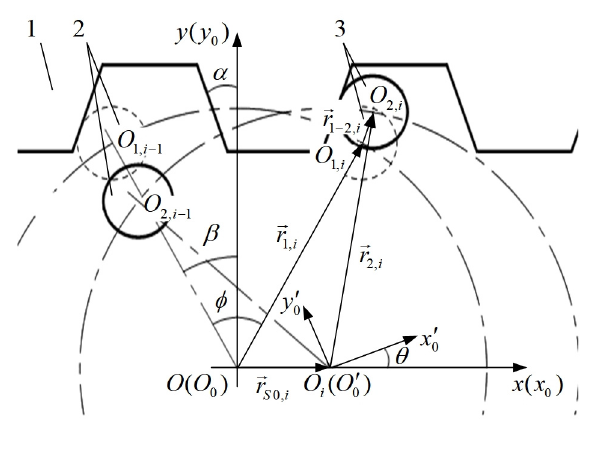
Figure 3. Position of the roller gear after rotation θ .